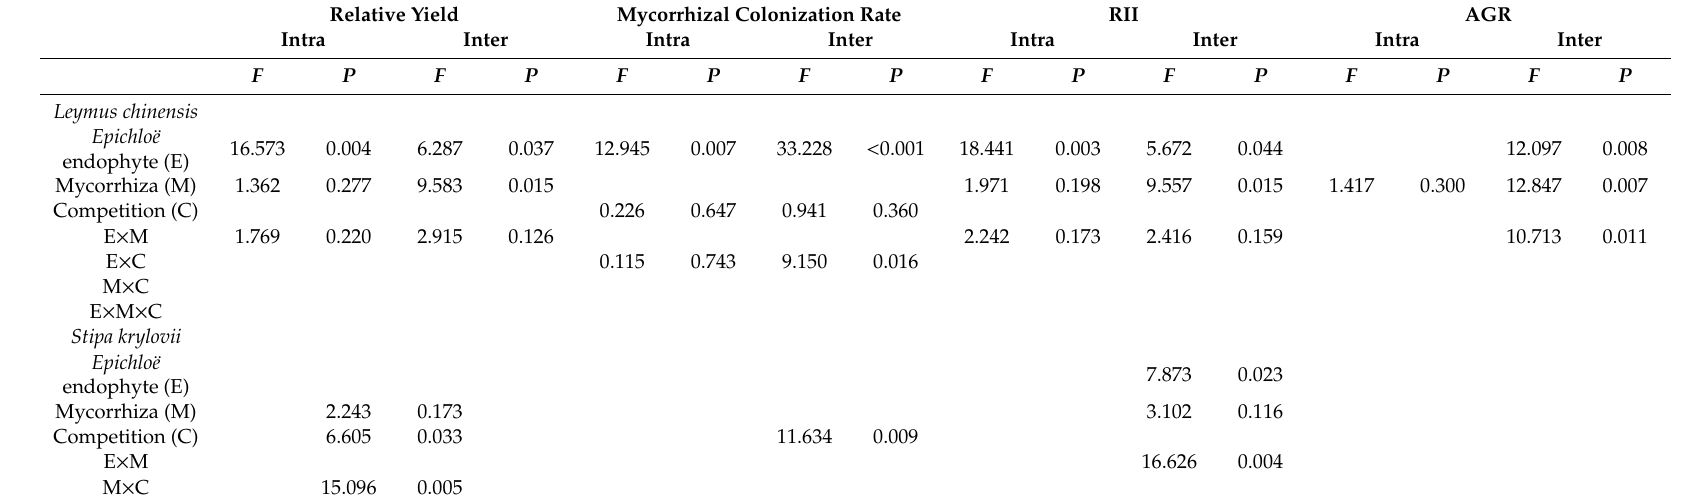
Table 2. Analyses of variance (ANOVA) for plant relative yield, mycorrhizal colonization rate, relative interaction intensity index (RII) and aggressivity index (AGR) of Leymus chinensis and Stipa krylovii